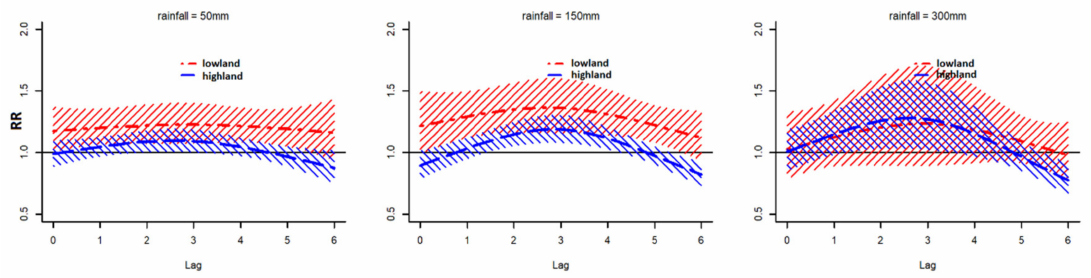
Figure 5. Pooled predictor-specific rainfall–malaria associations by